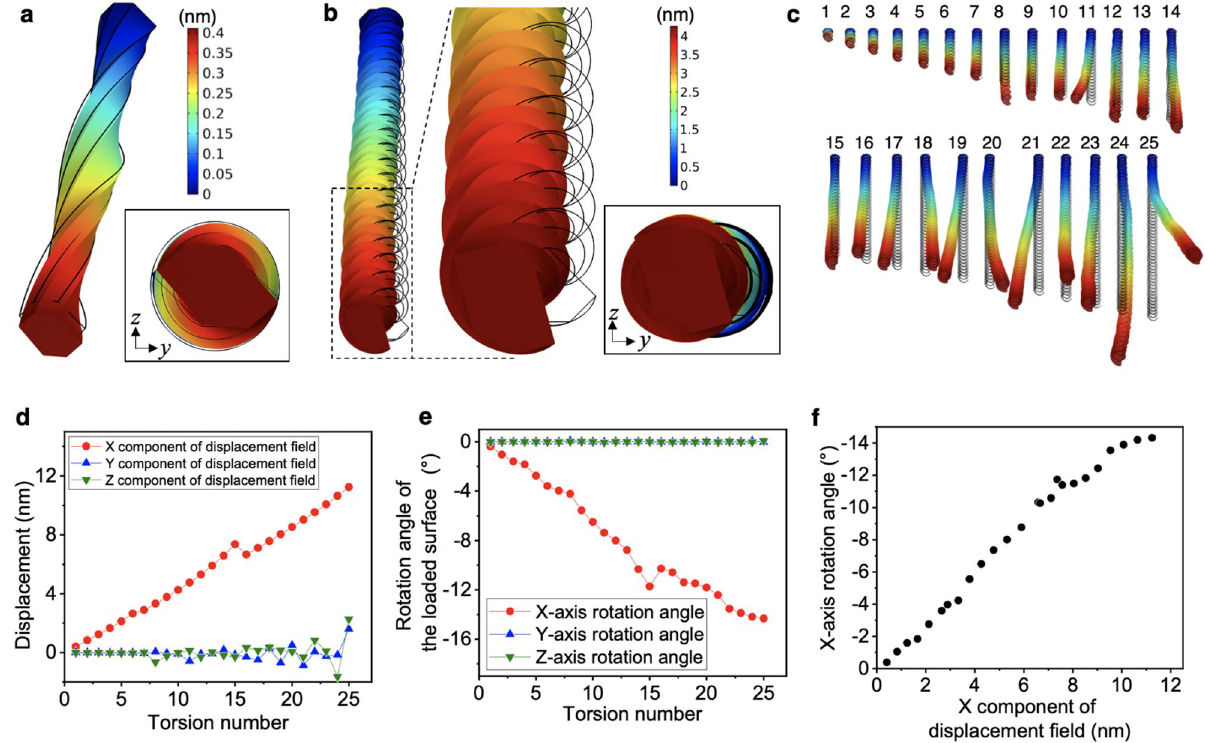
Figure 2. Mechanical simulation of a twisted CNF model. Displacement behaviour of the ( a ) 1- and ( b ) 10-round twist models, with 1 nN load from the original position indicated by the black lines. The displacement in the images for ( a ) and ( b ) was enlarged by 20 and 10 times for easy viewing, respectively. The inserts in both ( a ) and ( b ) are a cross-sectional view of the load plane. The colour bars indicate the total displacement. ( c ) Independent results of mechanical simulations for 1- to 25-round twist models with 1 nN load. The displacement in the image was enlarged by 10 times for easy viewing. ( d ) Displacements and ( e ) rotation angles in the x , y , and z directions plotted against the torsion number. ( f ) x -axis rotation angle plotted against the displacement in the x direction, showing a roughly inversely proportional relationship. The simulation model figures were exported by COMSOL Multiphysics 5.4 (https ://www.comso